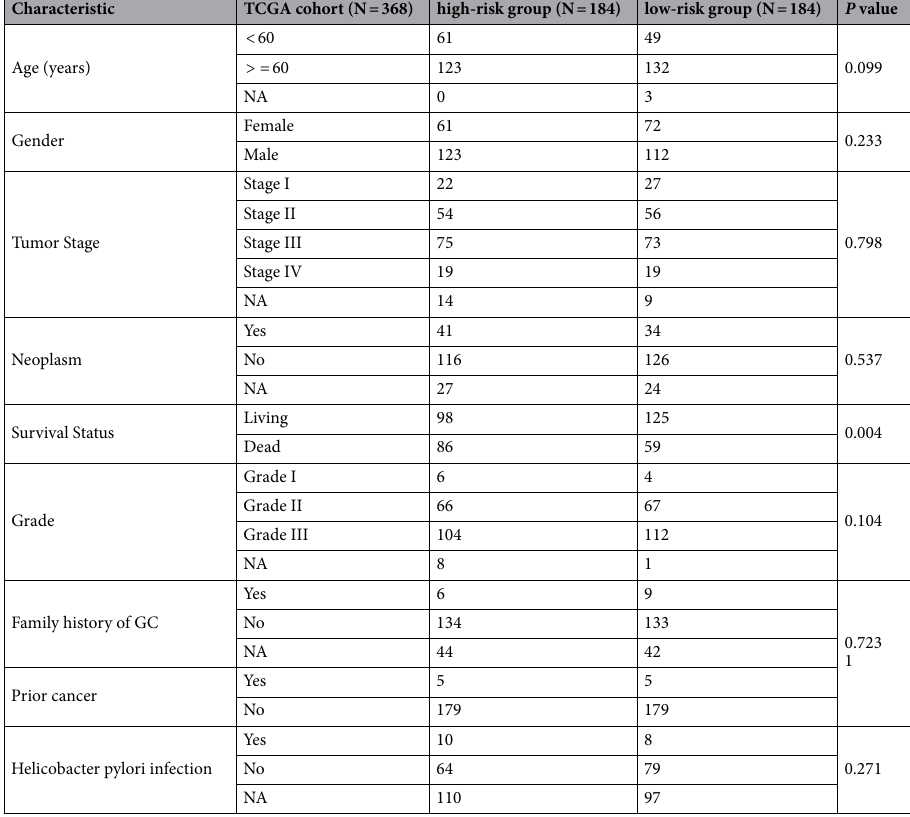
Table 1. Associations with risk group and clinical characteristics in the TCGA